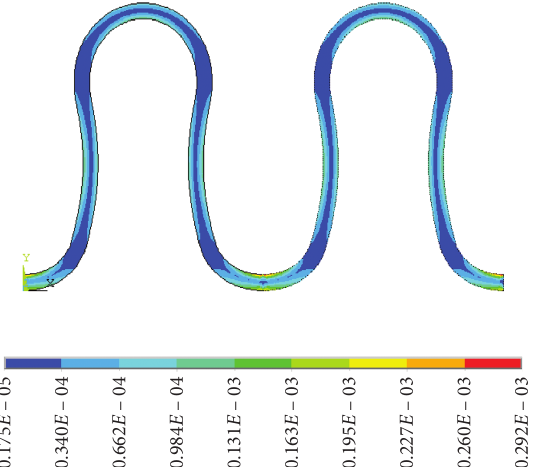
Figure 5: Strain distribution at air inlet and gas outlet side without considering thermal stress (Pa).